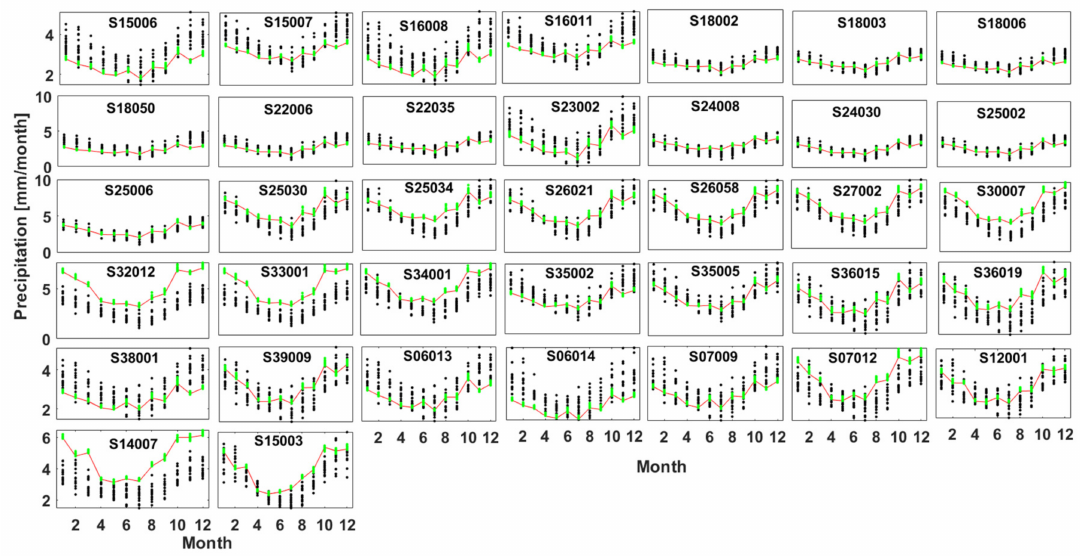
Figure 2. Comparison between raw (black dots) and bias-corrected (green dots) monthly mean precipitation from 12 Earth System Models (ESMs) and observations (red line) during the reference period 1976–2005 for each